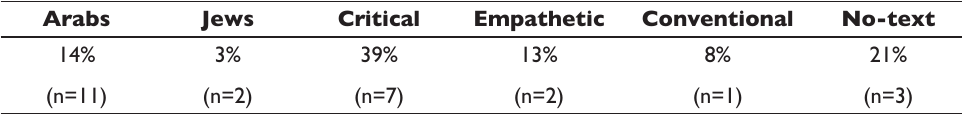
Table 1: Discussantsanddiscussiongroupsmakingreferencetofamilyhistories,byethnicgroupand